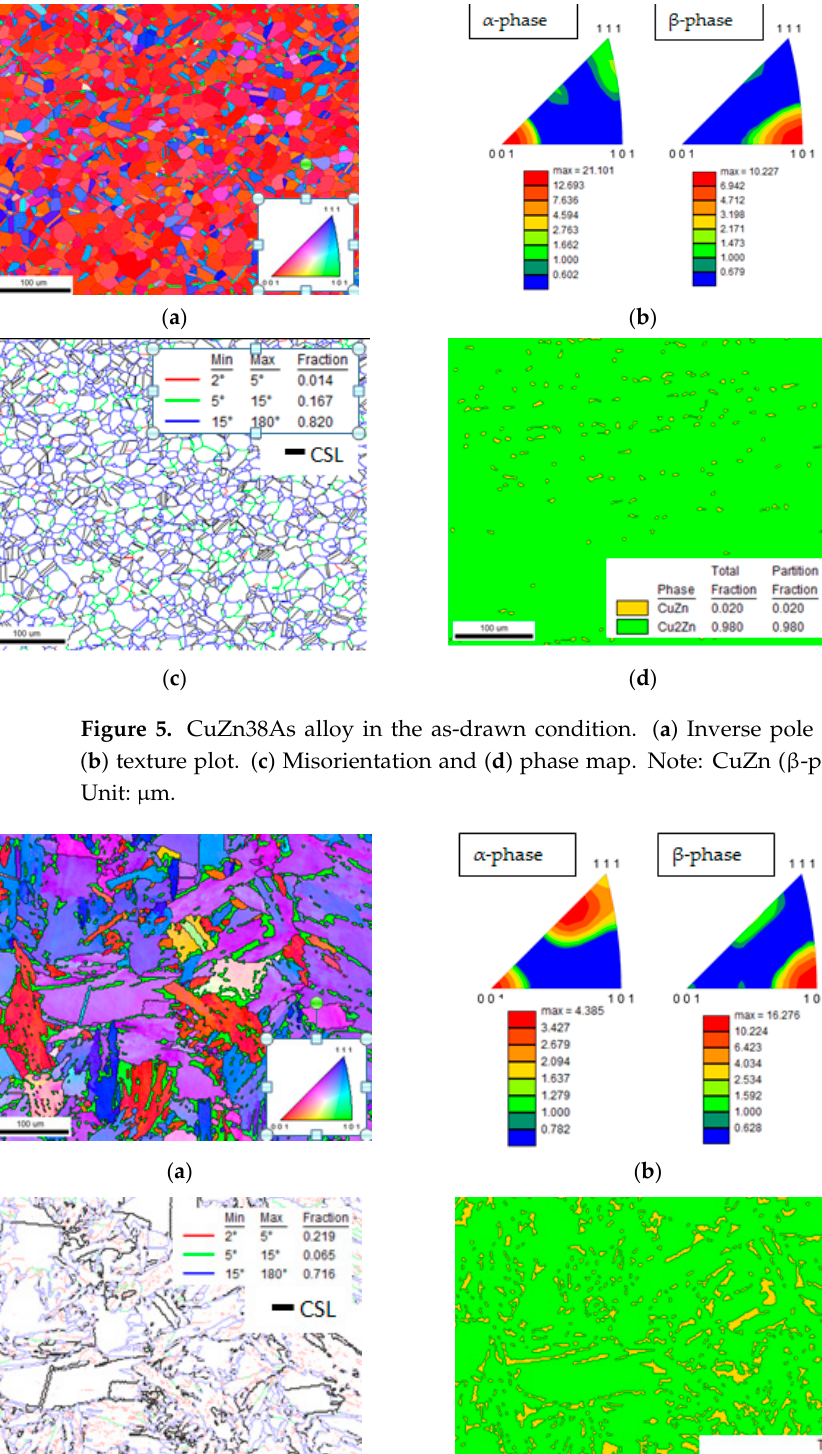
Figure 6. CuZn38As alloy in the heat treated condition. ( a ) Inverse pole figure (IPF-Z) map and ( b ) texture plot. ( c ) Misorientation and ( d ) phases map. Note: CuZn ( β -phase), Cu2Zn ( α -phase). Unit: µ